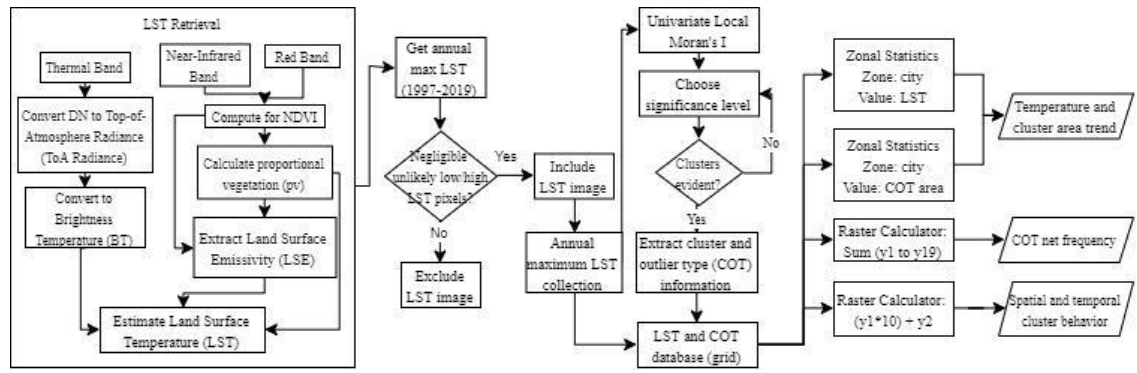
Figure 2. Process workflow for detecting Intra-Urban Heat Islands